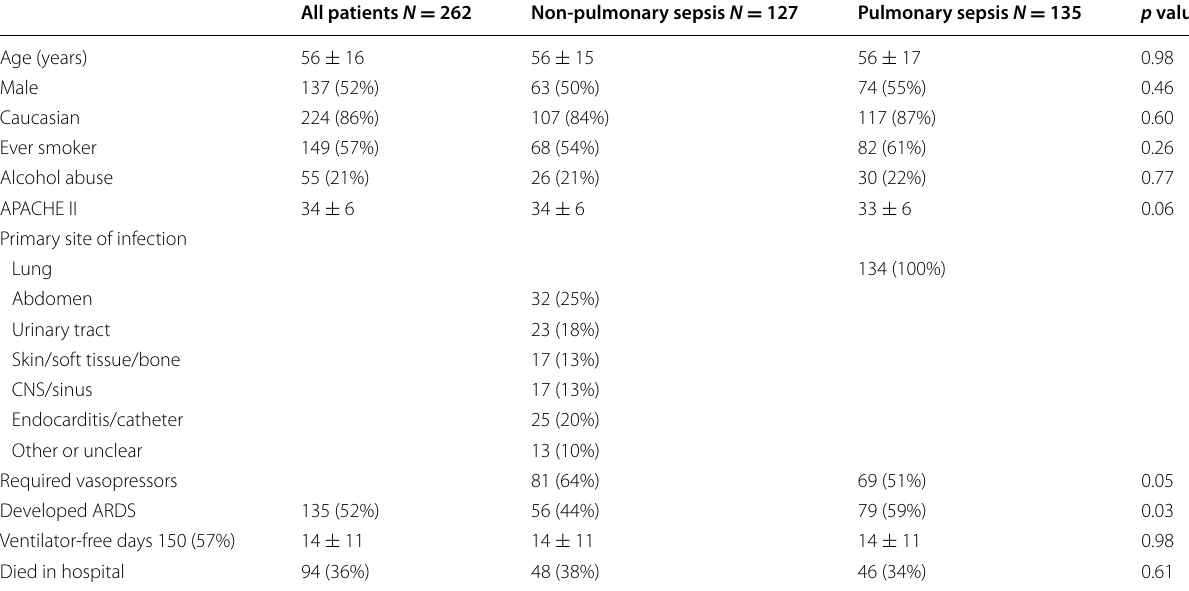
Data as mean SD or n (%) as indicated. p values compare characteristics of groups with pulmonary versus non-pulmonary sepsis by T test or Chi-square analysis as ± appropriate